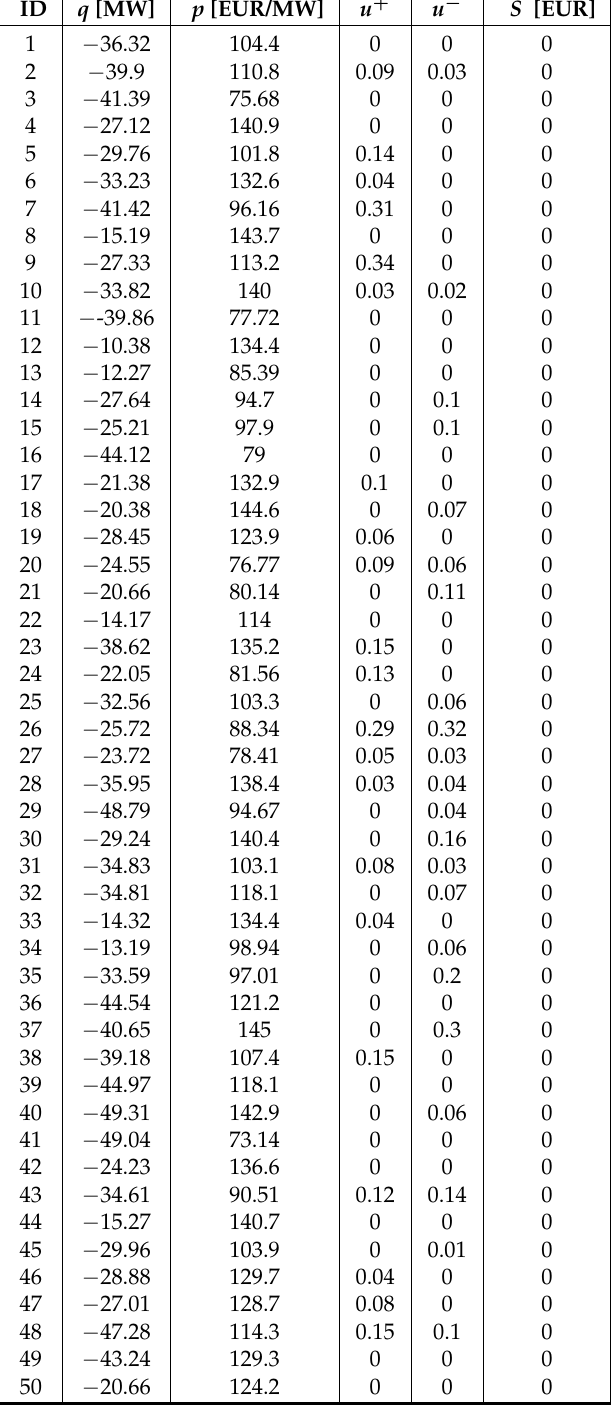
Table A3. Reference ED bid set: The columns correspond to the index of the bid (ID), quantity ( q ), bid price ( p ), positive and negative uncertainty ( u + , u − ), and S